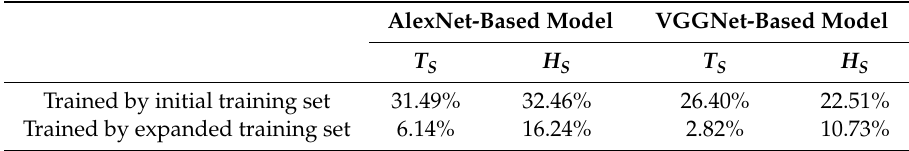
Figure 10. Inversion results of CNN-based models trained by the expanded training data set. Table 6. Inversion MRE (mean relative error) of CNN-based models trained by the initial and expanded training sets.